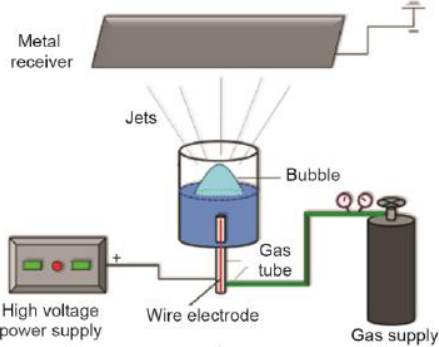
Figure 3. Schematic illustration of a critical bubble electrospinning system [27].